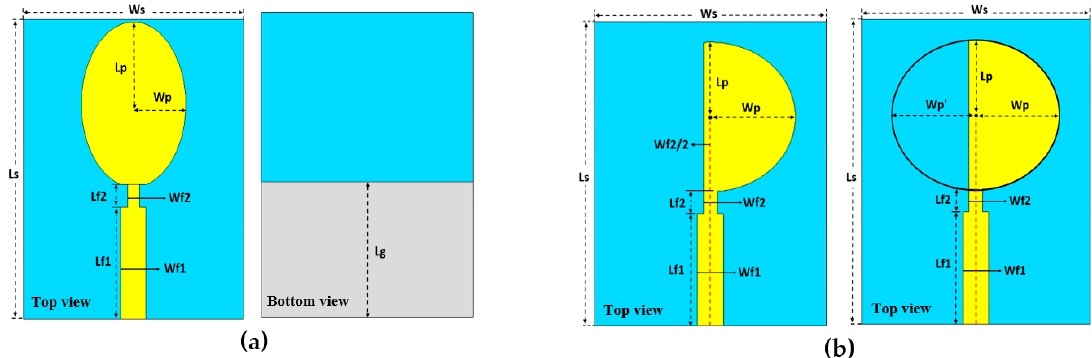
Figure 2. Geometry of a single UWB antenna, ( a ) reference UWB (ultrawideband) antenna, and ( b ) modified patch UWB antenna.